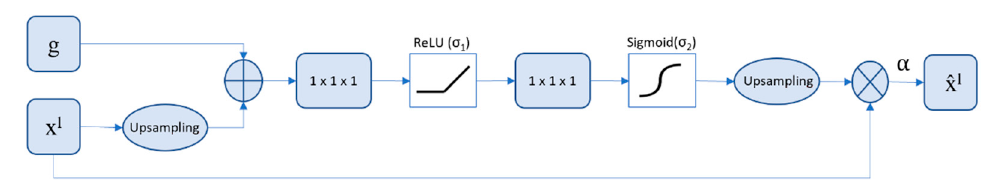
Figure 3. Illustration of attention gate (AG). Feature map upsampling was computed by bilinear interpolation.